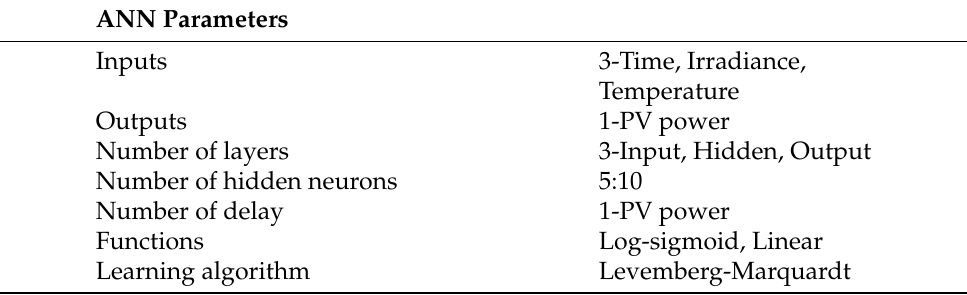
Table 4. Summary of dynamic Artificial Neural Network (ANN)